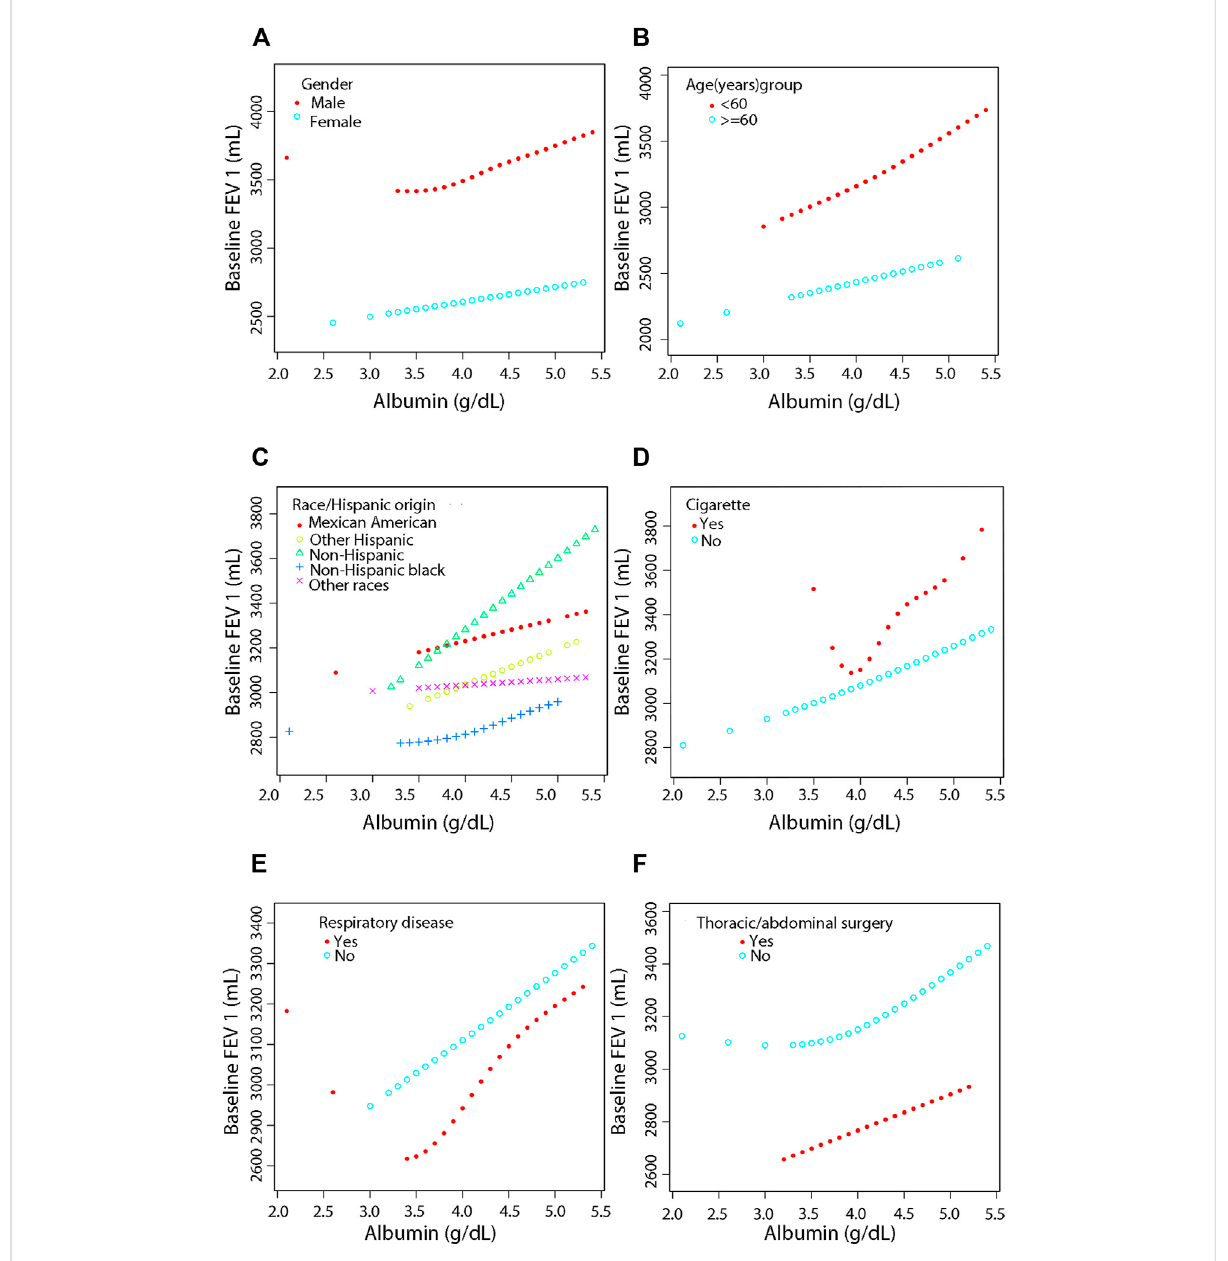
FIGURE 4 Association between serum albumin and Pulmonary Function (FEV 1) by covariate variables (gender, age, race, cigarette, respiratory disease, surgery). Weighted by: Exam weight in a full sample mobile examination center. Adjusted for globulin (smooth), age (smooth), gender, education level, race, surgery (yes, no), respiratory disease (yes, no), cigarette (yes, no), weight (smooth), standing height (smooth), diastolic blood pressure (smooth), systolic blood pressure (smooth), glucose, serum (smooth), cholesterol (smooth), creatinine (smooth), ALT (smooth), total calcium (smooth),sodium(smooth),potassium(smooth). (A) Strati fi edbygender. (B) Strati fi edbyagedichotomy. (C) Strati fi edrace. (D) Strati fi edbycigarette. (E) Strati fi ed by respiratory disease. (F) Strati fi ed by